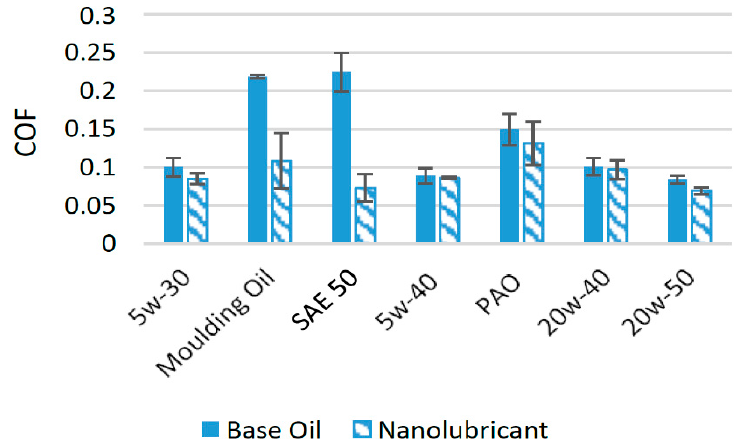
Figure 8. Effect of MoS 2 NPs on the friction performance of synthetic lubricants.